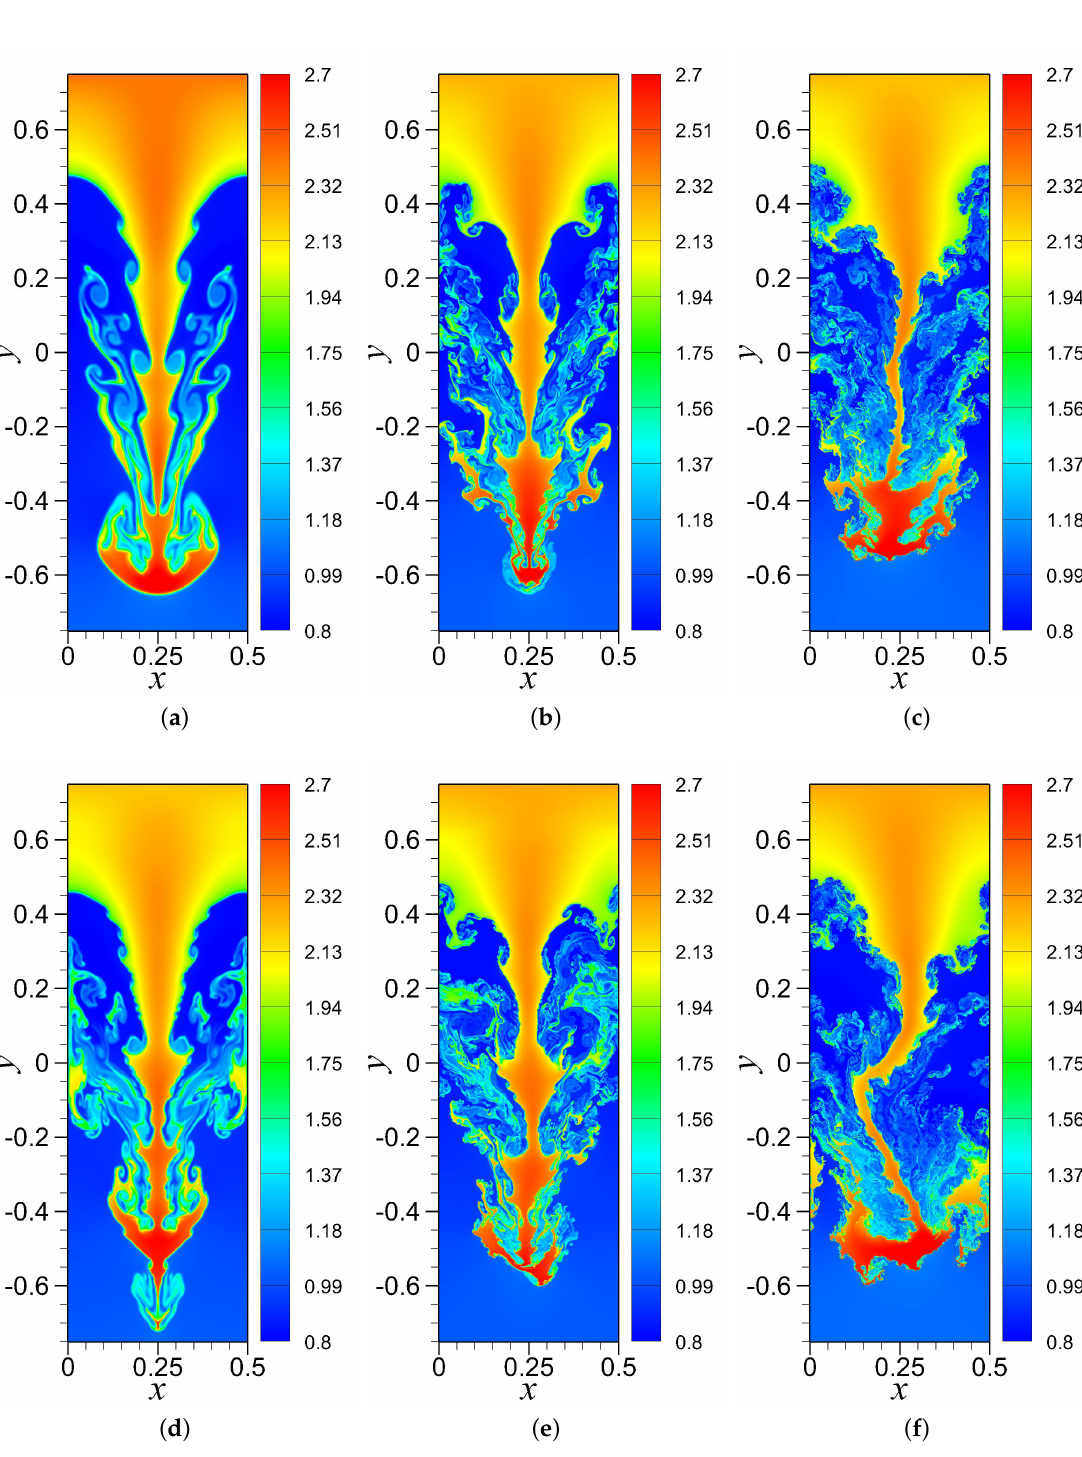
Figure 18. Density contours for the RTI problem with single-mode perturbation at t = 4.5 for different coarse grid resolutions and ILES schemes: ( a ) ILES-Rusanov with 256 × 768 resolution; ( b ) ILES-Rusanov with 1024 × 3072 resolution; ( c ) ILES-Rusanov with 4096 × 12288 resolution; ( d ) ILES-Roe with 256 × 768 resolution; ( e ) ILES-Roe with 1024 × 3072 resolution; ( f ) ILES-Roe with 4096 × 12288 resolution. The gravity is directed in a vertically downward